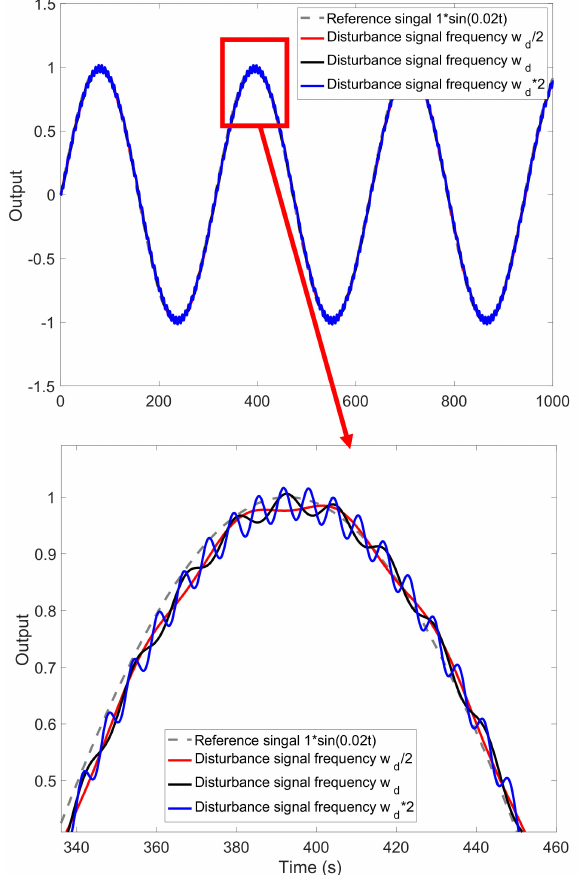
Figure 13. Robustness of the designed fractional-order controller to sinusoidal disturbance frequency variations.